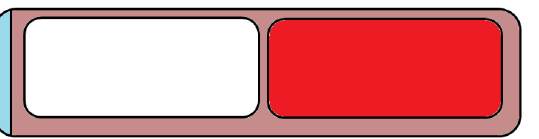
Figure 6. Cross-section of the dual-compartmental dosage form designed by Genina et al. In the research, isoniazid (white colored) and rifampicin (red colored) were hot-melt extruded and then 3D printed into the polymeric cap (brown colored) and closed with a cap (blue colored) [46].